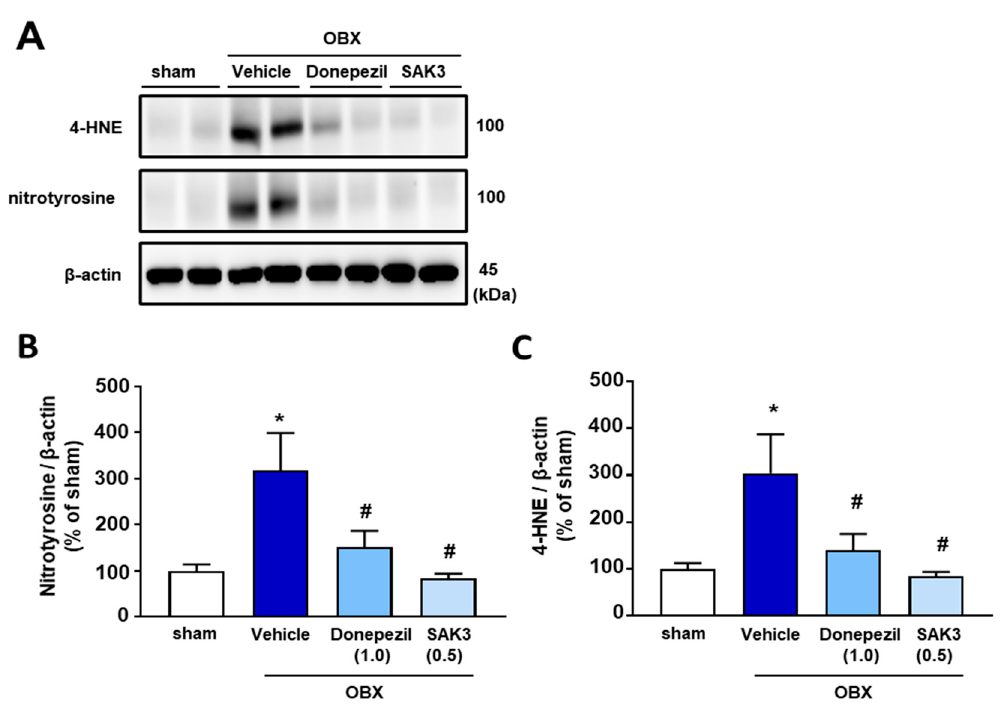
Figure 2. Elevated oxidative stress in OBX mice is suppressed by SAK3 and donepezil treatment in immunoblotting: ( A ) Representative image of western blots probed with antibodies against 4-HNE, nitrotyrosine or β -actin in the hippocampus; ( B , C ) Quantitative analyses of 4-HNE or nitrotyrosine protein levels (n = 10 per group). Error bars represent standard error of mean. * p < 0.05 vs. vehicle-treated sham mice; # p < 0.05 vs. vehicle-treated OBX mice.